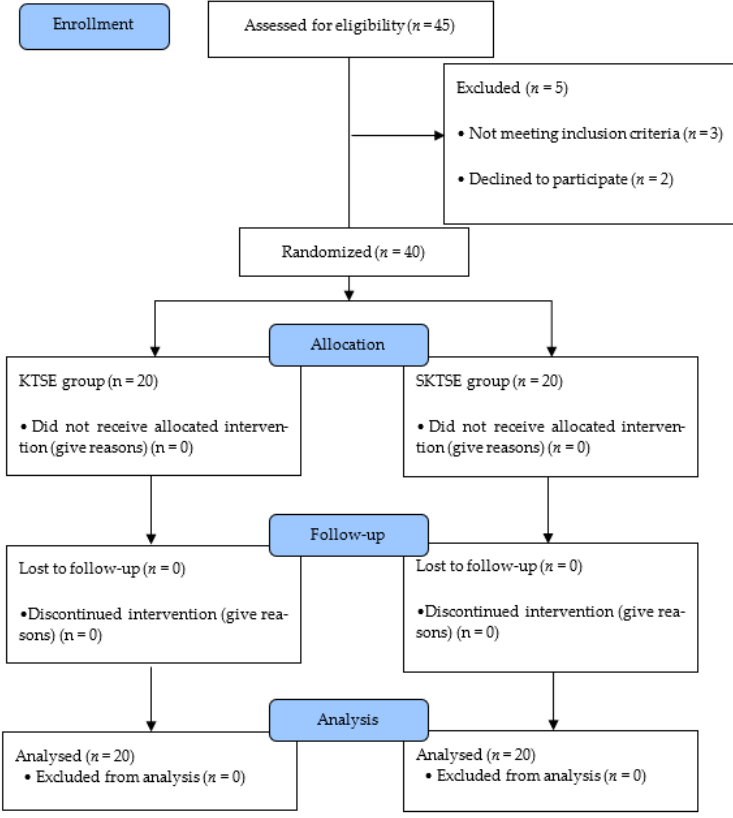
Figure 1. Flow diagram of the study.